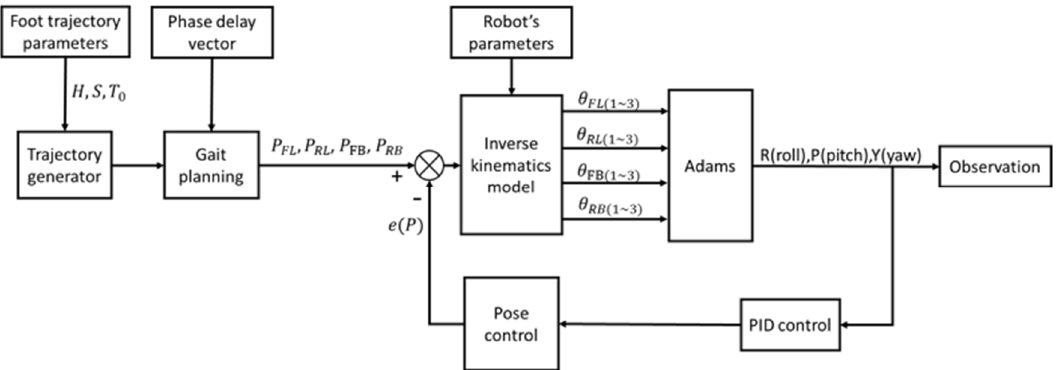
Figure 11. Control flow chart.